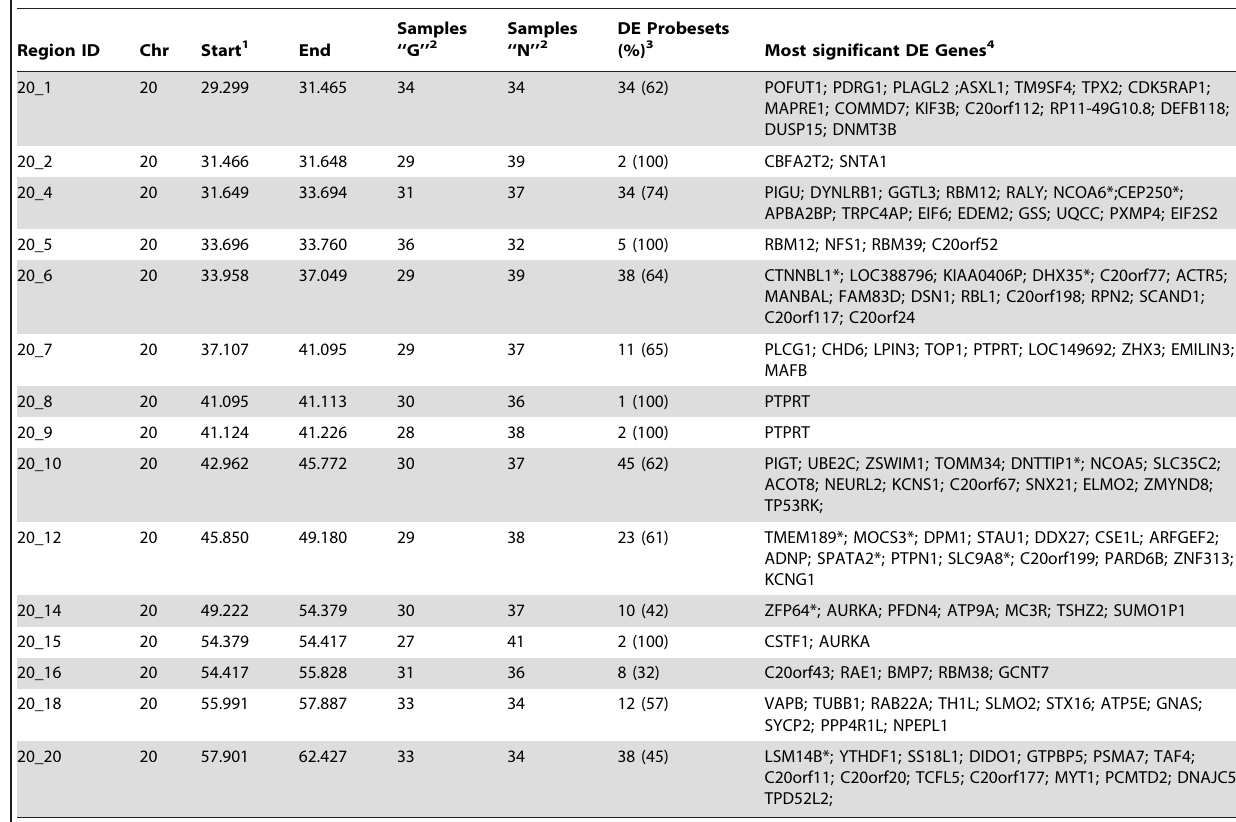
Table 4. Genes with increased expression on chromosome